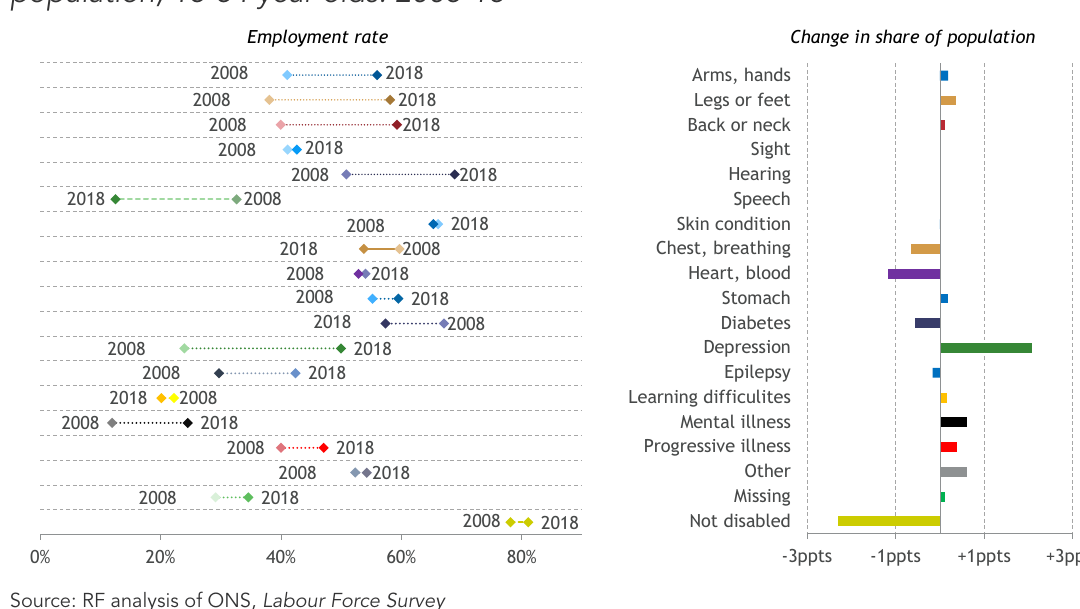
Figure 9: There has been a rise in the proportion of people reporting that they have a mental illness and a rise in employment rates for this group Employment and population changes by health problems of the disabled population, 16-64 year olds: